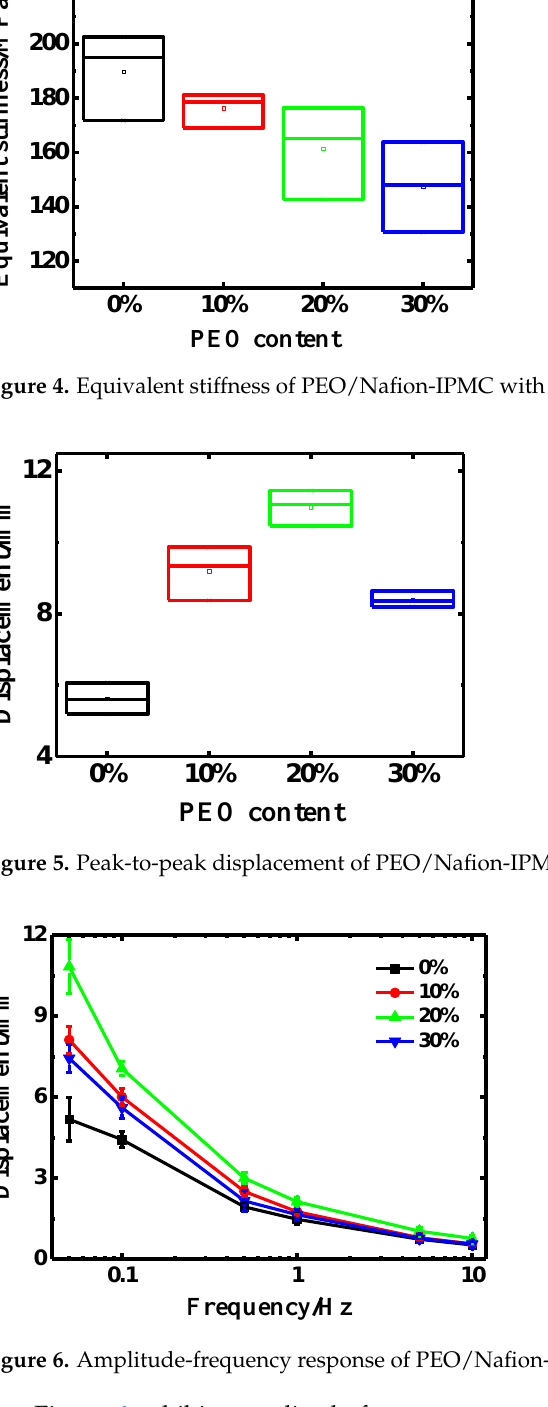
Figure 6. Amplitude − frequency response of PEO/Nafion − IPMC with varying PEO contents. The peak − to − peak blocking forces of the IPMCs with PEO contents of 0 wt%, 10 wt%, 20 wt%, and 30 wt% are presented in Figure 7. It can be seen that the blocking force, unlike the displacement of PEO/Nafion − IPMC, declined sharply with the addition of PEO in the Nafion matrix in comparison with the pure Nafion − IPMC. The average peak − to − peak blocking force of the pure Nafion − IPMC was 6.47 mN, while that of the PEO/Nafion − IPMC with 30 wt% PEO was as low as 4.73 mN. The results may be due to such impacts as the lower IEC, fewer counter ions, and significantly reduced equivalent stiffness with the addition of PEO.